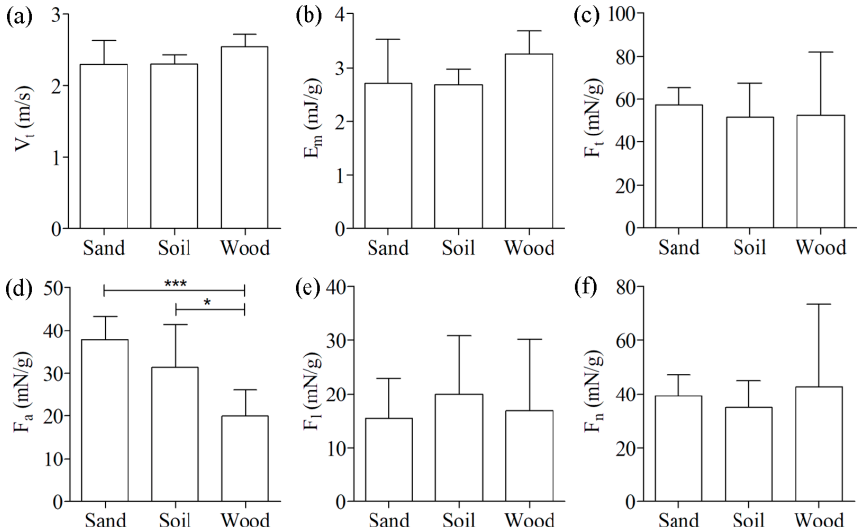
Figure 5. Comparisons of the kinematics and reaction force of locust jumps on three ground types: ( a )